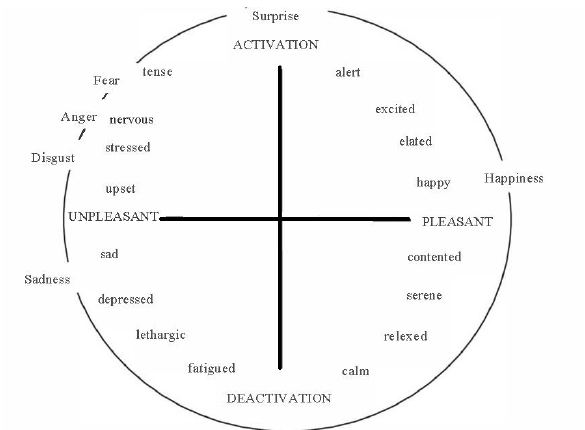
Figure 1. Classification of emotions based on the Core Affect (Barrett and Russell,